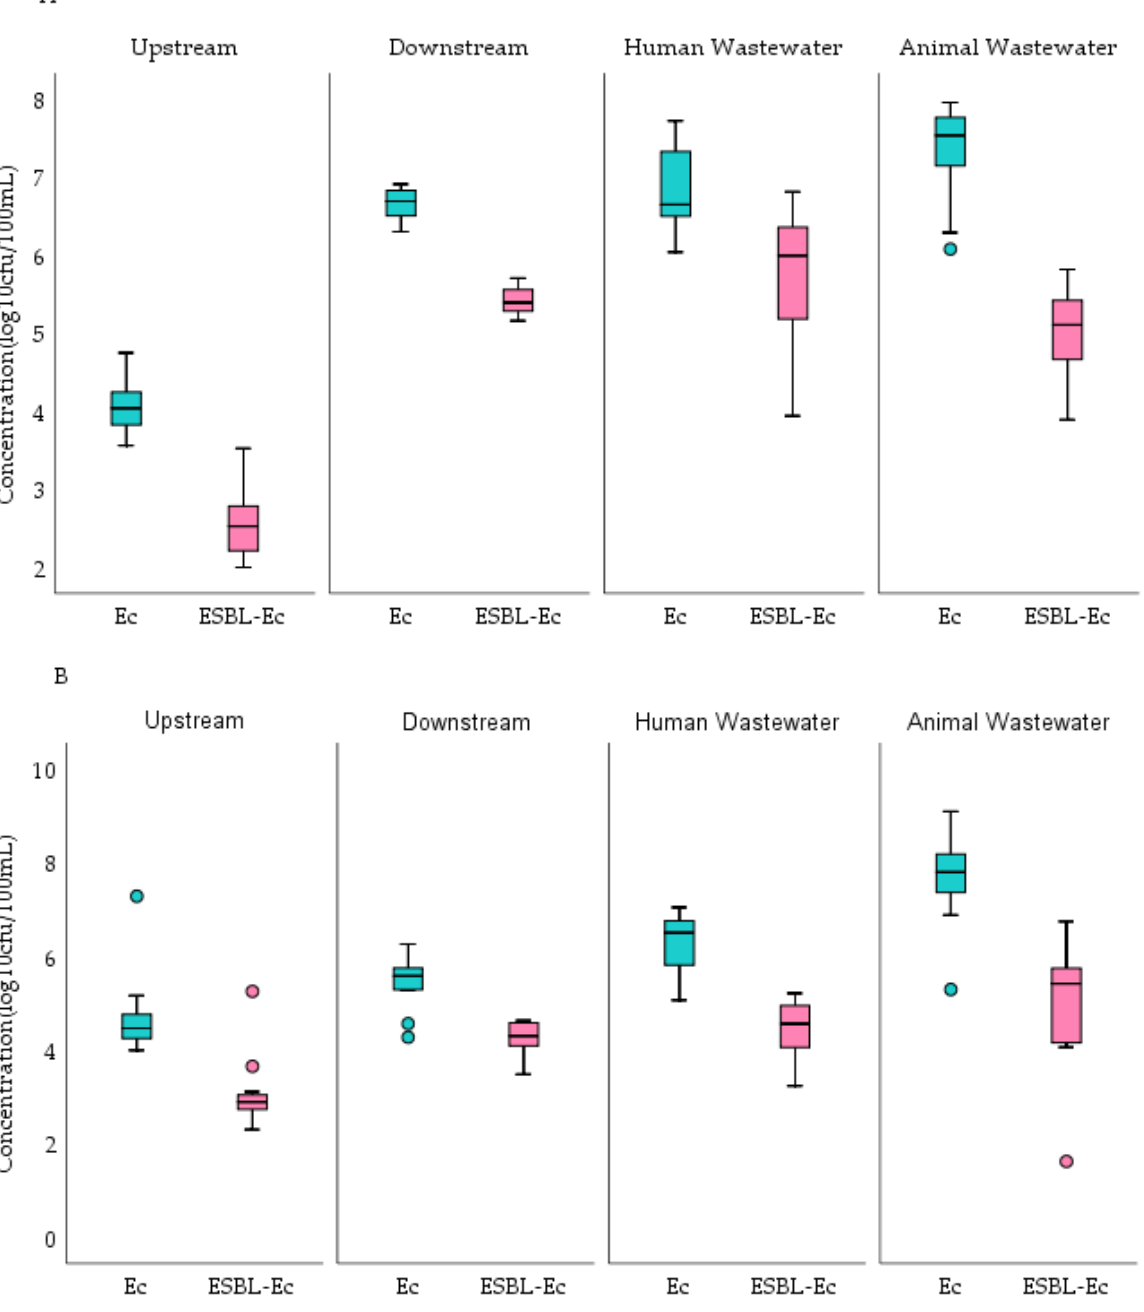
Figure 2. Comparison of concentrations of E. coli and ESBL-Ec among sampling sites in Accra ( A ) and Kasoa ( B ) for the periods of August 2018–December 2019, October 2019–February 2020, May, and Jun. 2020, Ec = E. coli , ESBL-Ec = Extended-Spectrum Beta-Lactamase E. coli , cfu = colony forming units.